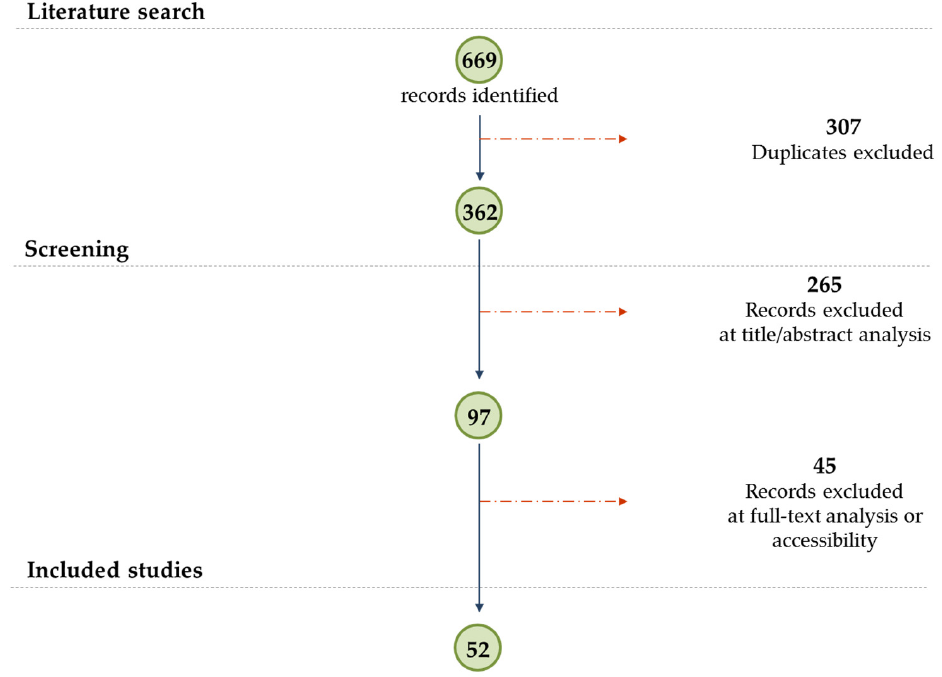
Figure 1. PRISMA (Preferred Reporting Items for Systematic reviews and Meta-Analyses) flow diagram of the study search strategy and selection process.